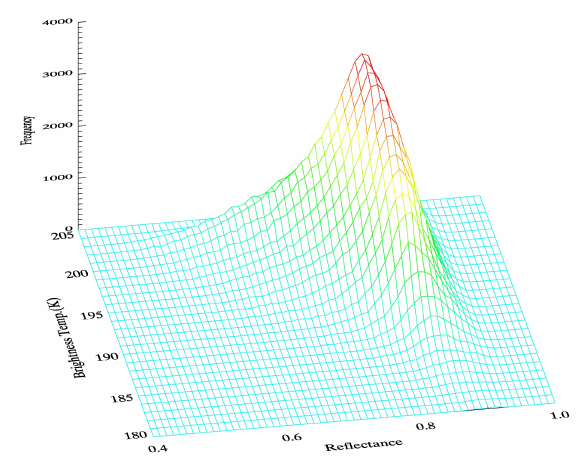
Figure 8. Two-dimensional histogram of DCCs detected using AHI R 0.47 and TB 10.4 over the GEMS observation area with AHI data taken at three-day intervals for the period July 2016–June